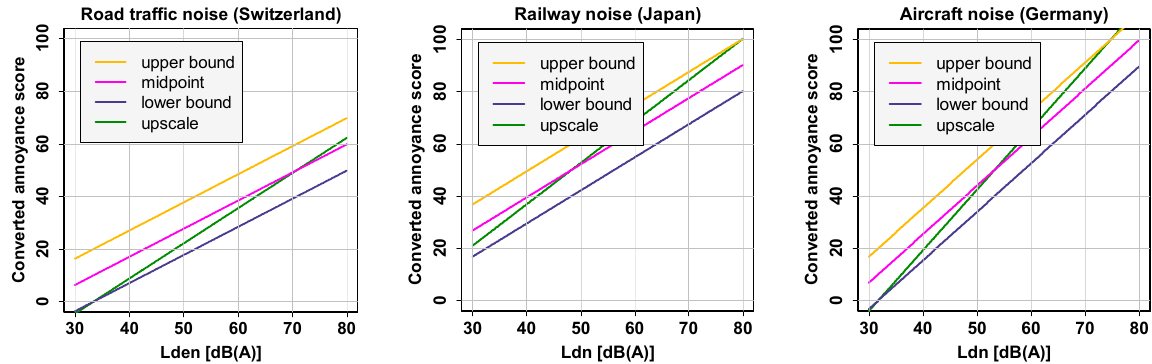
Figure 1. Examples of linear regression lines resulting from modeling with four different scale conversions of the 5-point scale, as listed in Table 2: Left, road traffic noise in Switzerland (whole country) [7]; center, railway noise in Japan (Sapporo) [8]; right, aircraft noise in Germany (Frankfurt) [9] .